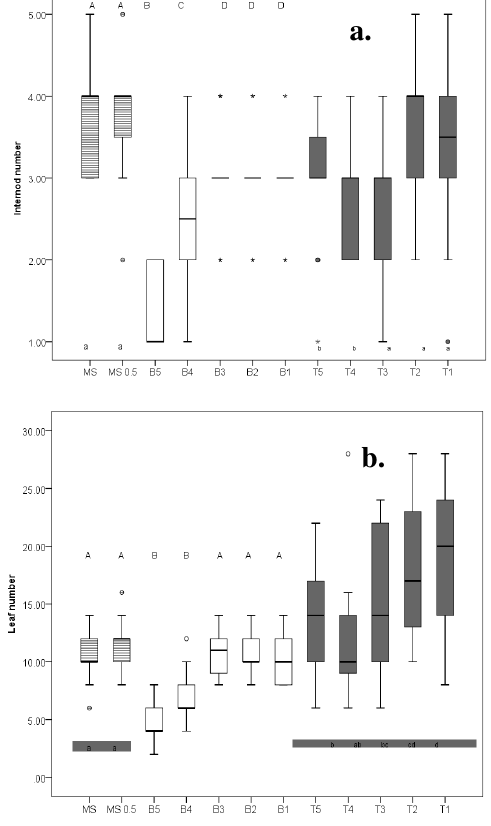
Fig. 4. Internodes numbers (a); NMS, MS1/2, B5-3, T1-5=20, N B2=15, NB1=10; Kruskall-Wallis, post-hoc comparison: Mann-Whitney U test, NMS, MS1/2, B5-3, T1- 5= 20, NB2=15, NB1=10; Leaf numbers (b); NMS, MS1/2, B5-3, T1-5=20, NB2=15, NB1=10; Kruskall-Wallis, post-hoc comparison: Mann-Whitney U test, NMS, MS1/2, B5-3, T1- 5= 20, NB2=15, NB1=10; Significant differences are represented by different characters,